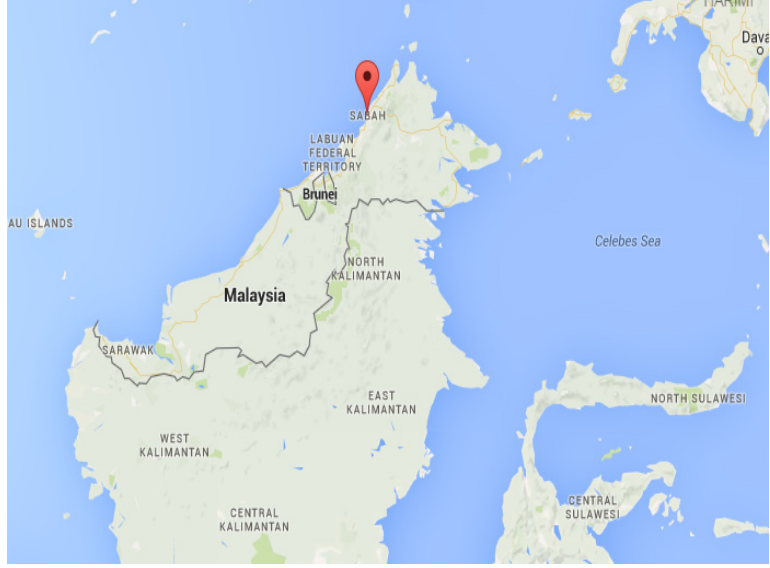
Figure 1. The location of Kota Kinabalu